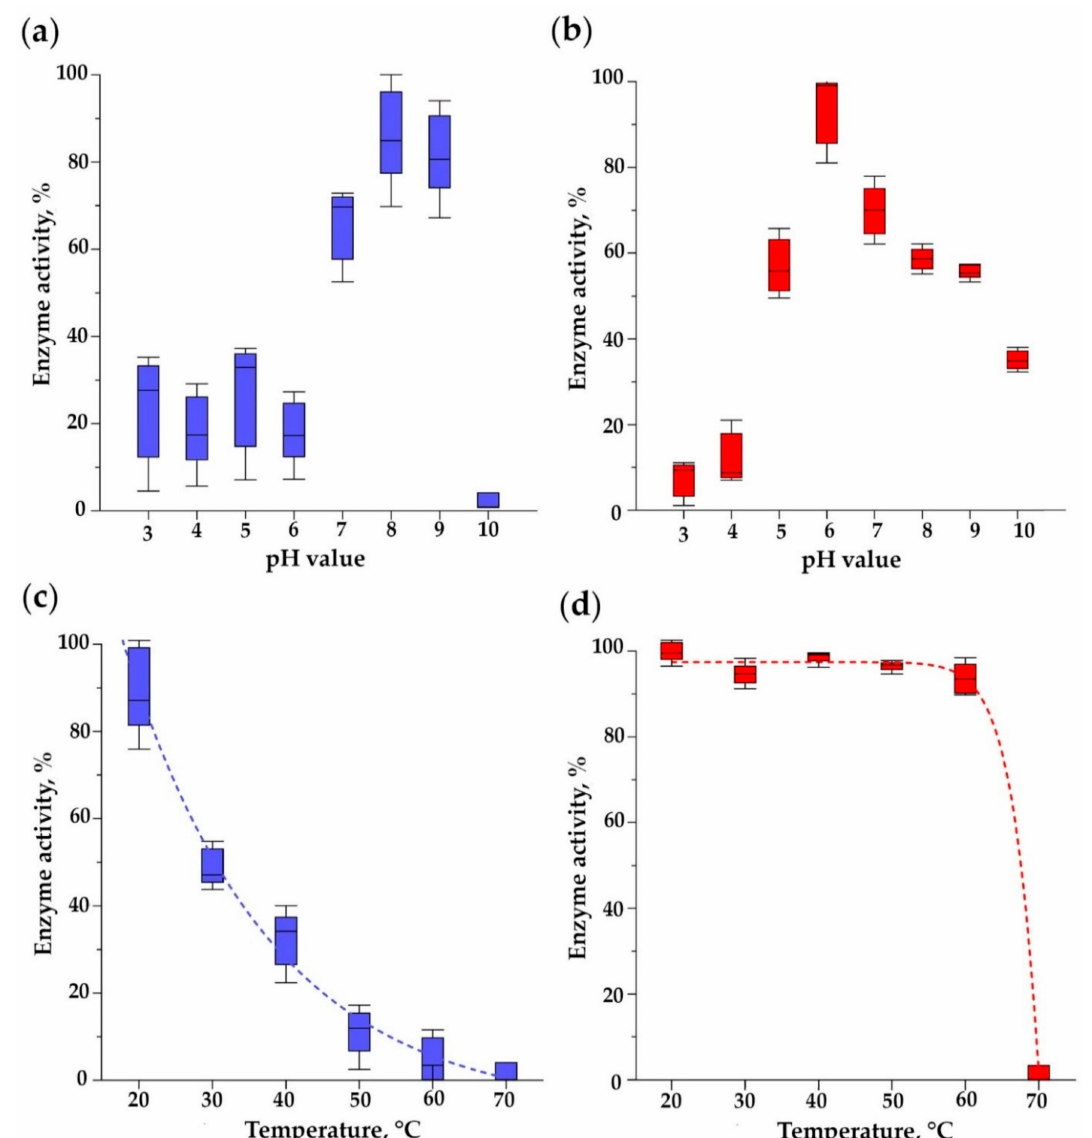
Figure 10. The bacteriolytic activity of ( a ) HU-Gp82 and ( b ) HU-Gp84 endolysins at different pH values at 35 ◦ C. The residual activity of ( c ) HU-Gp82 and ( d ) HU-Gp84 endolysins after 1 h incubation at different temperatures. The graphs were created with GraphPad Prism 8.4.3 with a 95% confidence interval. Five independent trials were performed in the